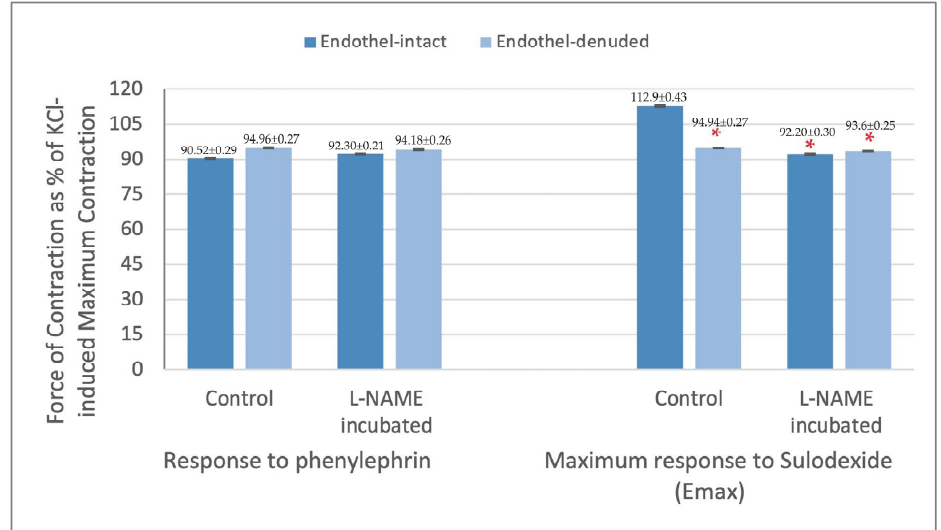
Figure 3. Contraction response of endothelium-intact and denuded saphenous vein strips to phenylephrine (6 × 10 − 7 M) and maximum responses (Emax) obtained with sulodexide application presented as % of KCl-induced contraction. * p < 0.05 when compared with Emax obtained from endothelium-intact control rings.